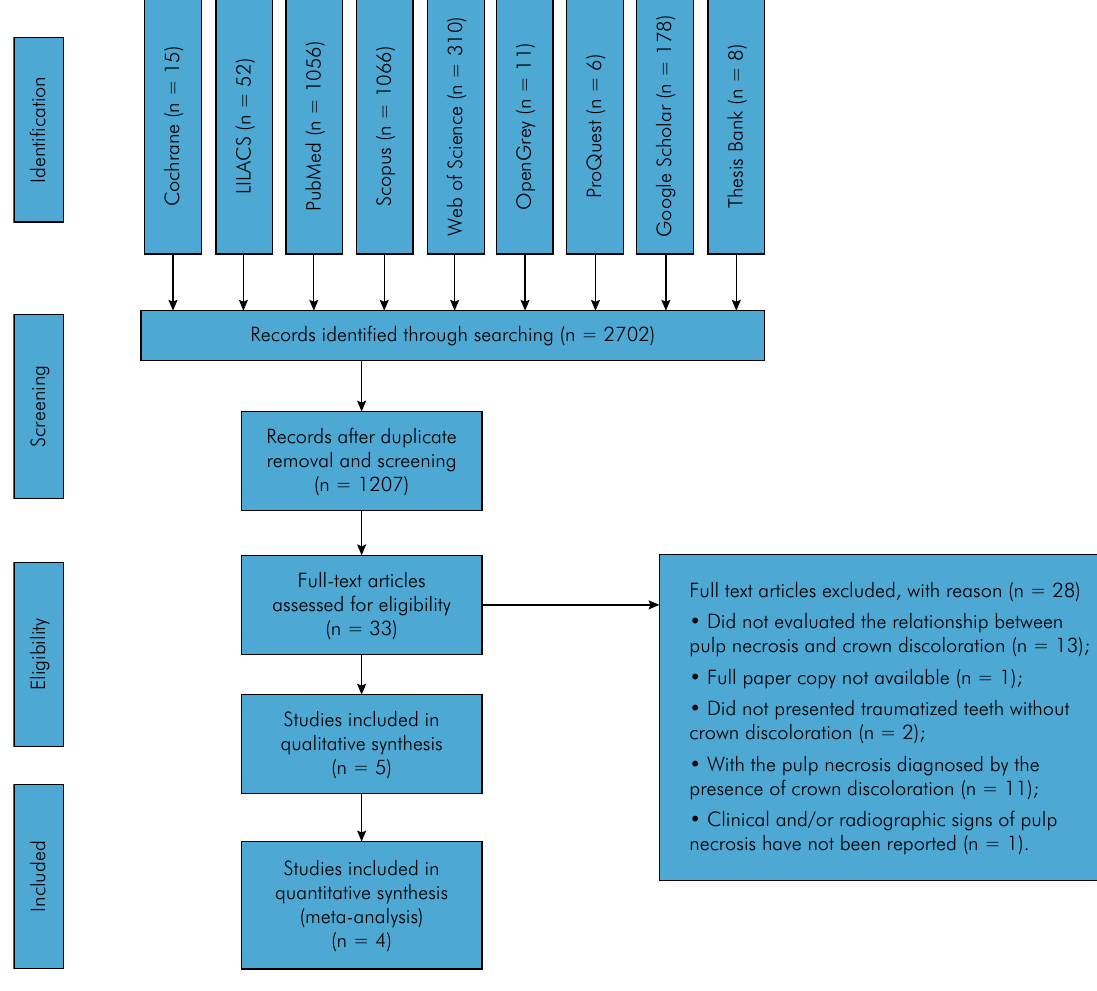
Figure 1. Flowchart diagram of literature search and selection criteria according to the PRISMA